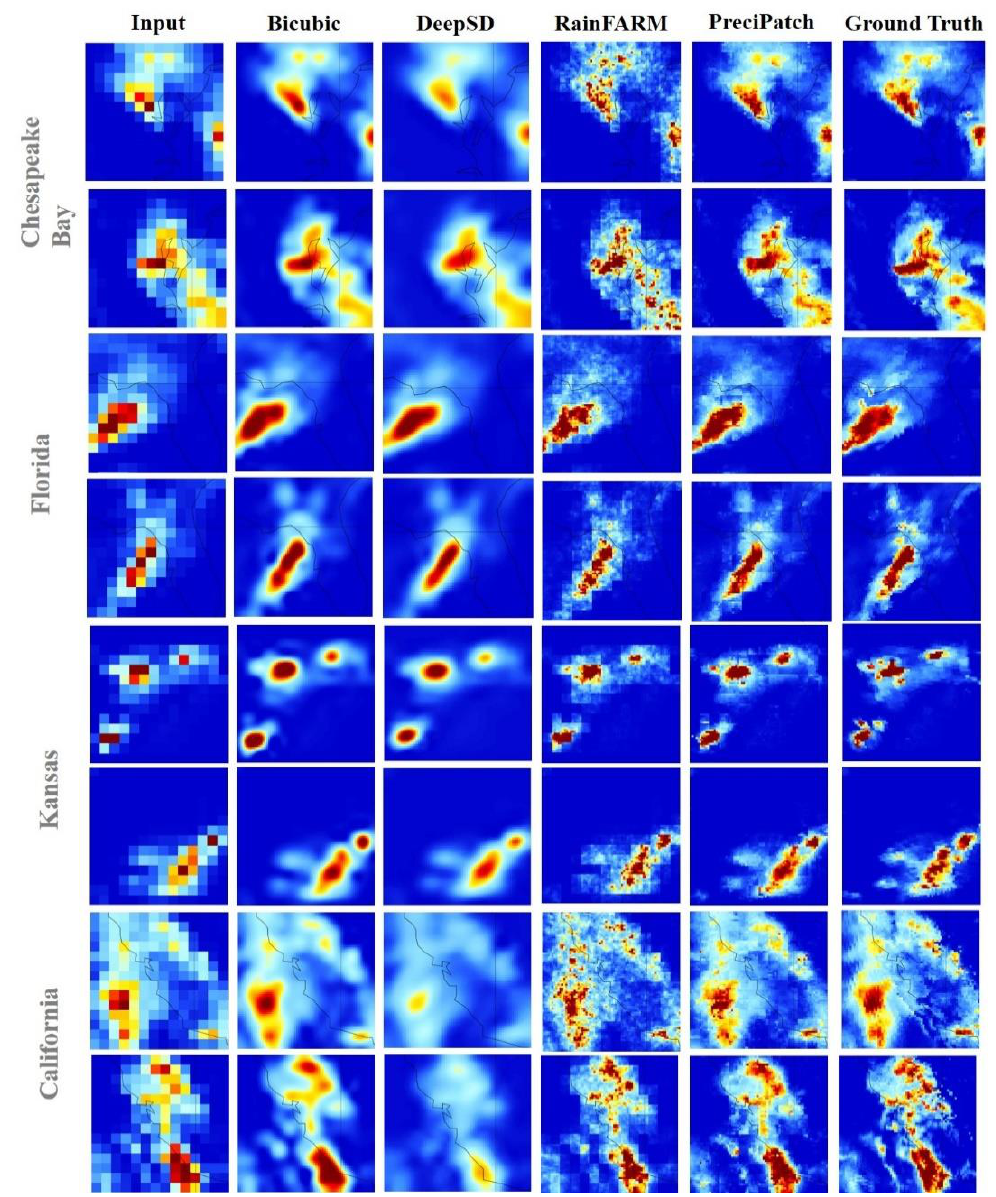
Figure 5. Downscaling results. The x-axis refers to the longitude, and the y-axis refers to the latitude. Each row is the input aggregated Integrated Multi-satellitE Retrievals for GPM (IMERG) rain rate, Bicubic result, DeepSD result, RainFARM result, PreciPatch result and original high-resolution IMERG rain rate respectively for each location. 1st row: hourly precipitation at Chesapeake Bay area on 2018/7/21 (23:30:00 UTC), 2nd row: hourly precipitation at Chesapeake Bay area on 2018/7/21 (16:30:00 UTC), 3rd row: hourly precipitation at Florida area on 2018/12/14 (05:30:00 UTC), 4th row: hourly precipitation at Florida area on 2018/12/14 (18:30:00 UTC), 5th row: hourly precipitation at Kansas area on 2018/7/29 (04:30:00 UTC), 6th row: hourly precipitation at Kansas area on 2018/7/29 (08:30:00 UTC), 7th row: hourly precipitation at California area on 2018/1/9 (00:30:00 UTC), 8th row: hourly precipitation at California area on 2018/1/9 (08:30:00 UTC).